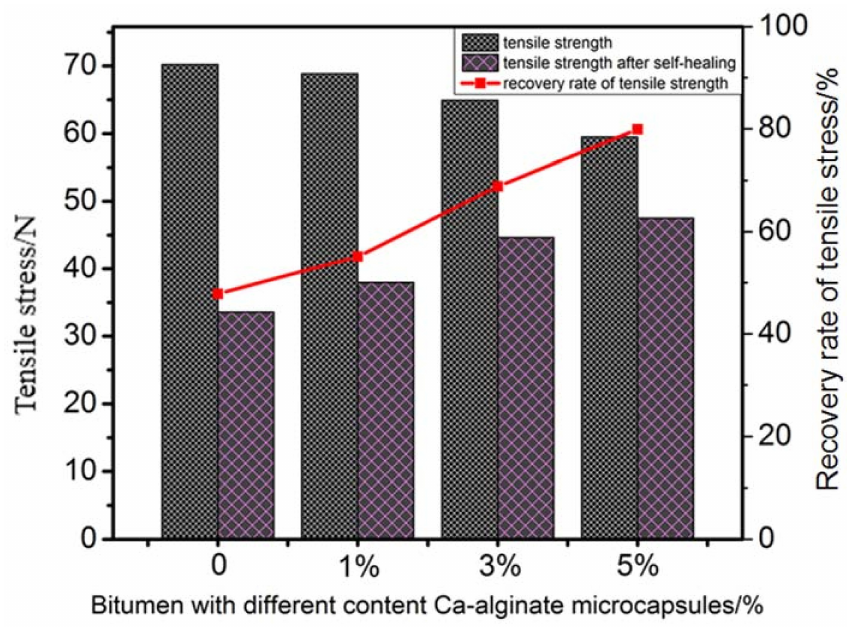
Figure 11. Tensile stress and recovery rate of bitumen with different content Ca-alginate